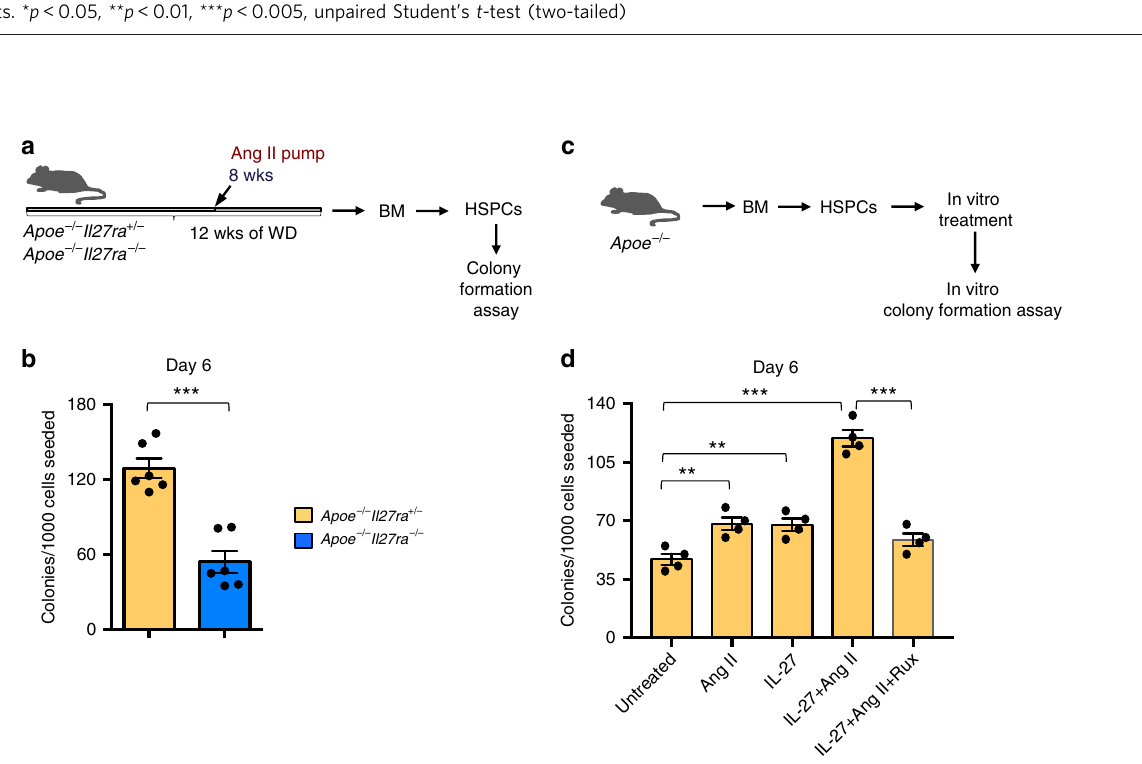
Fig. 3 IL-27R de fi ciency leads to limited expansion of HSCs in response to Ang II. BM was obtained from Apoe − / − Il27ra + / − ( n = 7) and Apoe − / − Il27ra − / − ( n = 5), or Apoe − / − Il27ra + / − ( n = 12) and Apoe − / − Il27ra − / − ( n = 12) mice fed with WD for overall period of 12 weeks and infused with PBS or Ang II for last 4 weeks of feeding, respectively. a Representative dot plots of live LSK (Lin − Sca-1 + c-kit + ) and myeloid progenitors (Lin − Sca-1 − c-kit + ). b Representative dot plots of live LT-HSC (Lin − Sca-1 + c-kit + CD150 + CD48 − ) and HPC-1 (Lin − Sca-1 + c-kit + CD48 + CD150 − ) cells. c Average percentage of live LSK, LT-HSC, HPC-1, myeloid progenitors, and CMP (Lin − Sca-1 − c-kit + CD16/CD32 − CD34 + ). d Absolute number of live LSK, LT-HSC, HPC-1, myeloid progenitors, and CMP. e Proliferation of HSPCs from Apoe − / − Il27ra + / − ( n = 8) or Apoe − / − Il27ra − / − ( n = 6) mice fed with WD and infused with Ang II or PBS as determined by BrdU incorporation. Percentage of live BrdU-positive LSK and myeloid progenitors, including LT-HSC, HPC-1, and CMP. Data are mean ± SEM from two independent experiments. f Percentage of progenitor cells from Apoe − / − Il27ra + / − ( n = 6) or Apoe − / − Il27ra − / − ( n = 6) mice infused with Ang II in G 0 /G 1 and G 2 /M phase of cell cycle, analyzed for BrdU inclusion, and DAPI staining. Data are mean ± SEM from three independent